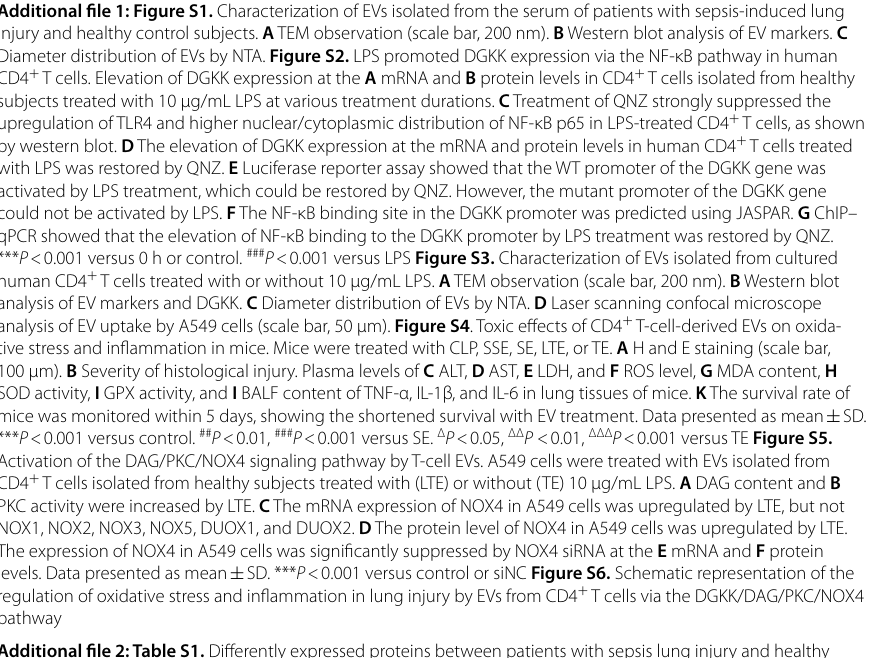
Additional file 2: Table S1. Differently expressed proteins between patients with sepsis lung injury and healthy subjects by using LC–MS/MS analysis Acknowledgements Not